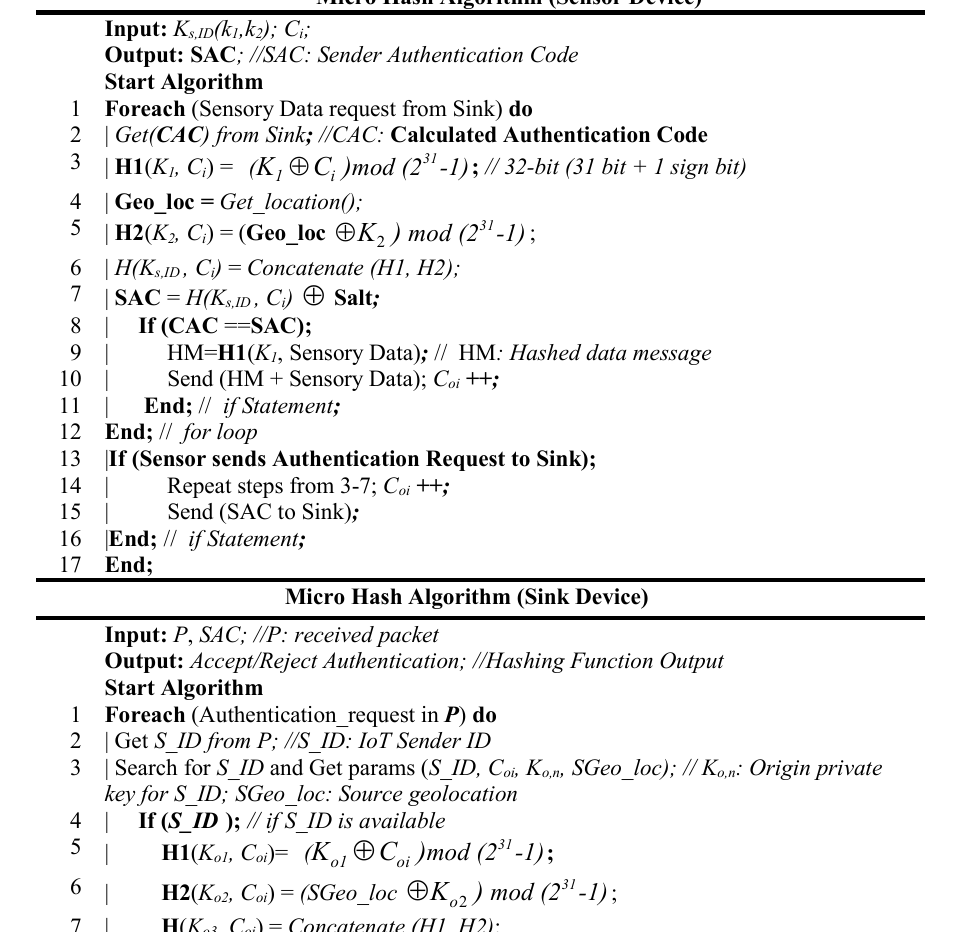
Micro Hash Algorithm (Sensor Device)